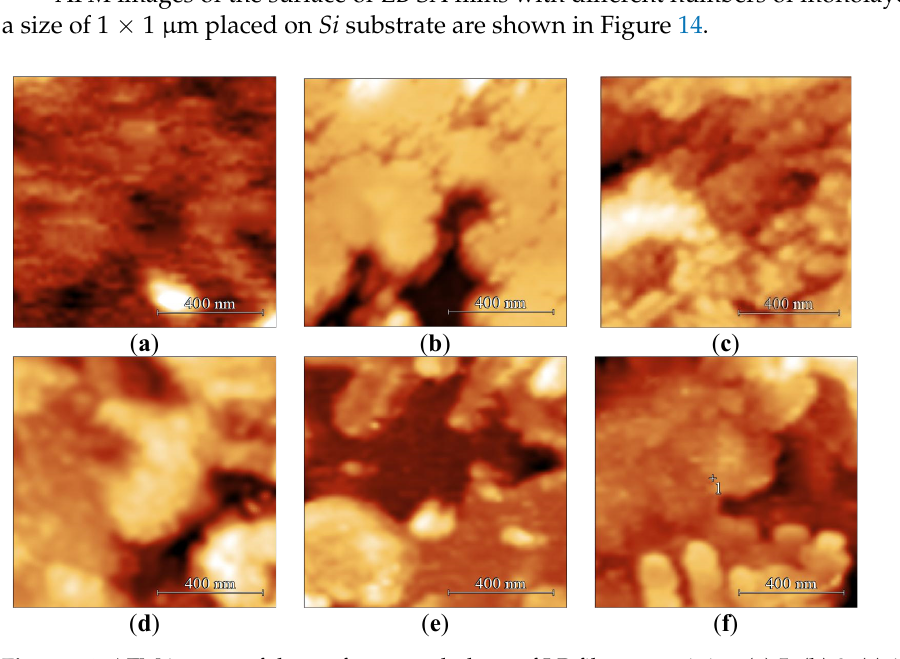
Figure 14. AFM images of the surface morphology of LB films containing ( a ) 5; ( b ) 9; ( c ) 13; ( d ) 17, ( e ) 21; and ( f ) 25 monolayers of stearic acid made at a surface pressure of 30 mN/m and placed on Si substrate. Si